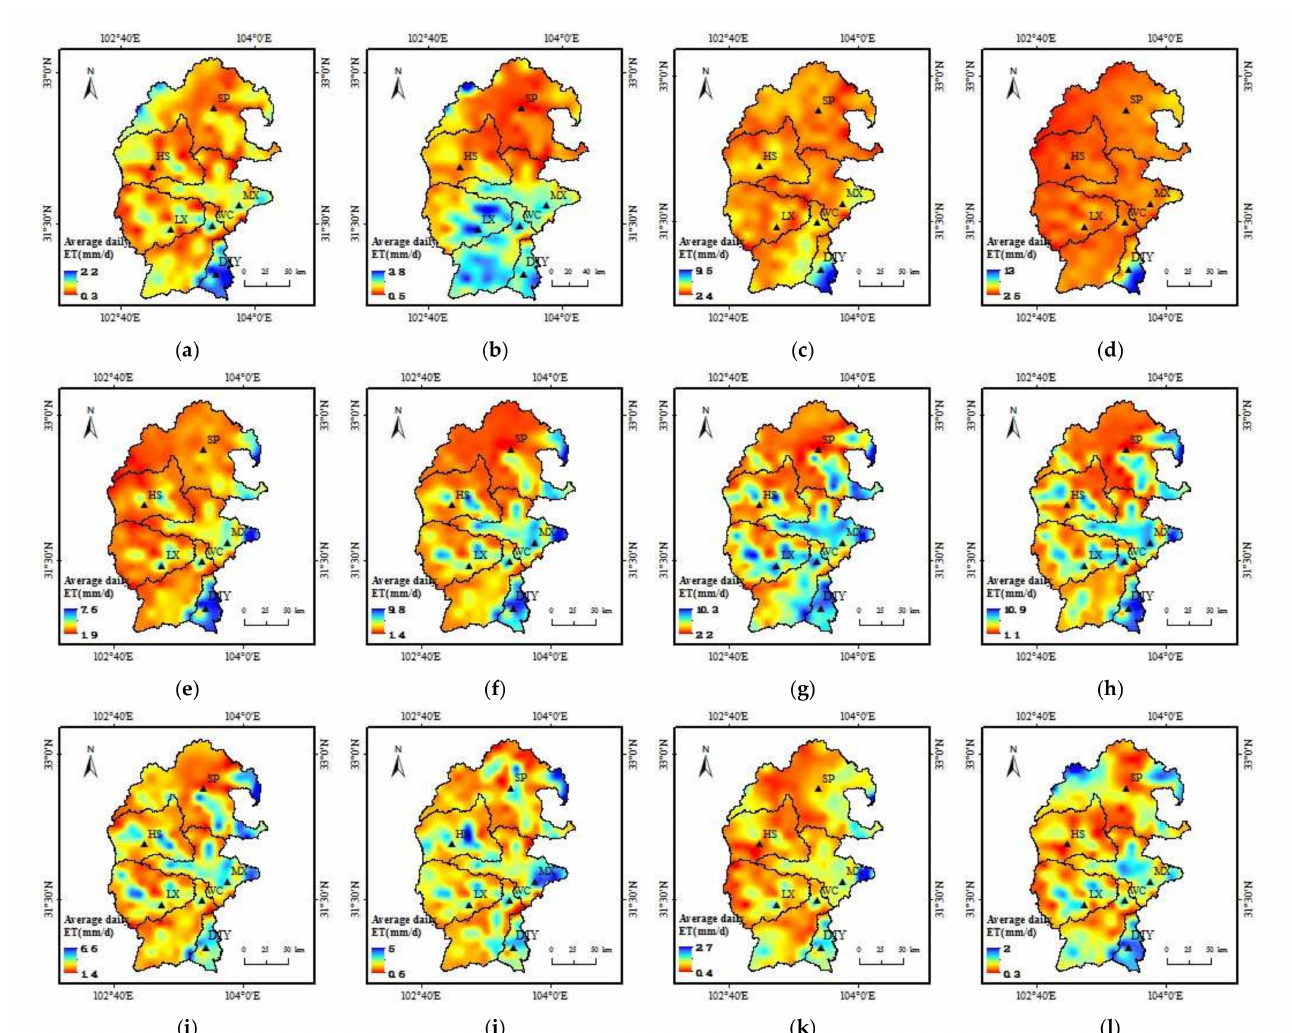
Figure 8. Spatial and temporal of ET in six counties. ( a – l ) are the average daily ET in six counties.